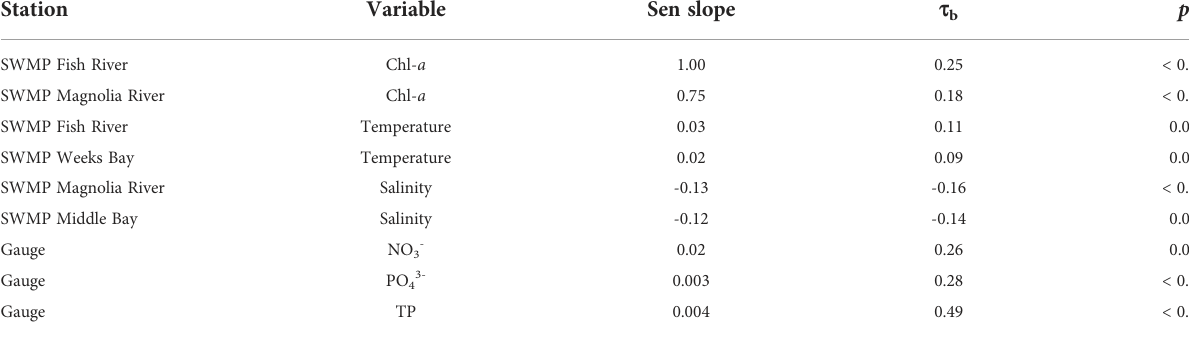
TABLE 4 Sen slopes and t b for variables with signi fi cant ( p < 0.05) Seasonal Kendall monotonic trends at SWMP stations and the gauge.